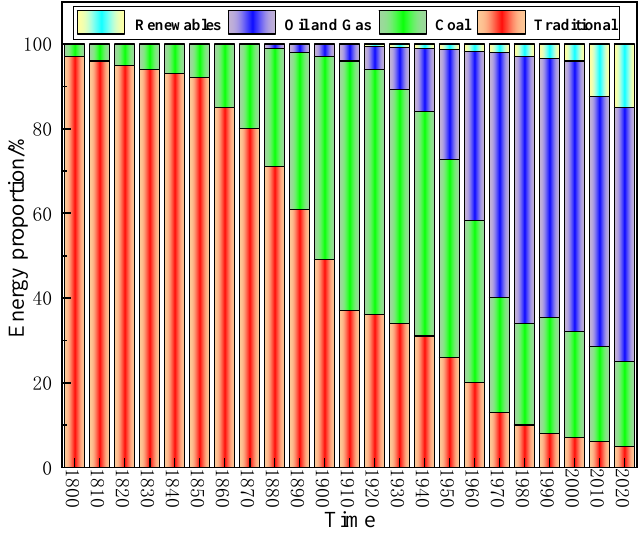
Figure 2. Share of global energy consumed and the change in global primary energy consumption [7].